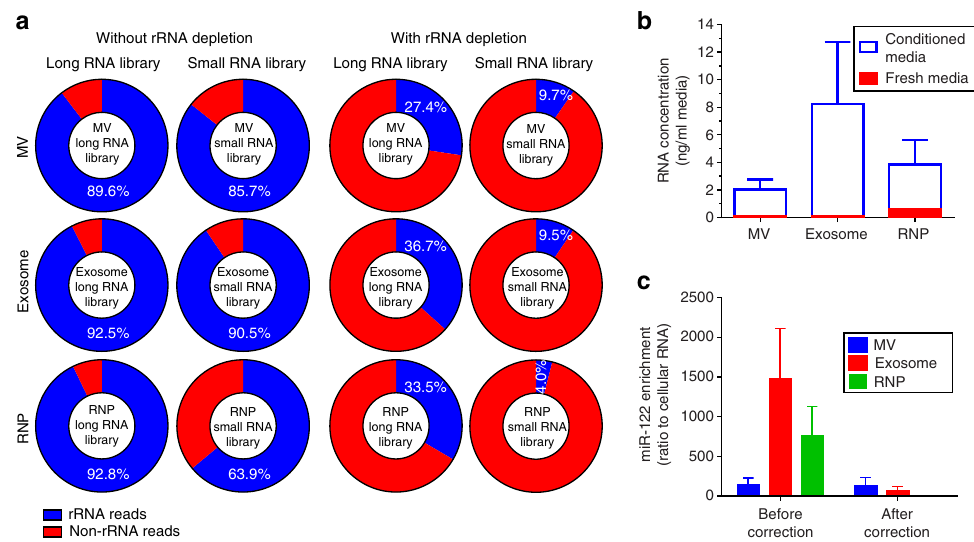
Fig. 3 rRNA depletion and media correction are warranted for the deep RNAseq analysis. a Comparison of the exRNA libraries prepared with and without rRNA depletion. The percent of rRNA reads is shown, indicating that the majority of exRNA reads in non-depleted libraries represent rRNA. Sequencing depth of other exRNA classes is substantially increased by the rRNA depletion. b Quanti fi cation of total RNA in conditioned and fresh media indicates that the vast majority is cell derived ( n = 4 GSC cultures). Nevertheless, quanti fi cation of speci fi c RNA species can be skewed by the media, as illustrated in c . The levels of miR-122 were assessed in exRNA isolated from the fractions of conditioned and fresh media. miR-122 enrichment in exRNA ( n = 4 GSC cultures) was calculated pre- and post-correction to the levels in fresh media, as described in Supplementary Fig. 6. miR-122 was highly enriched in the GSC exRNA, relative to its intracellular level, with up to 1500-fold enrichment in the exosomes before media correction. miR-122 enrichment in GSC exosomes became marginal upon correction. All bars represent mean ±